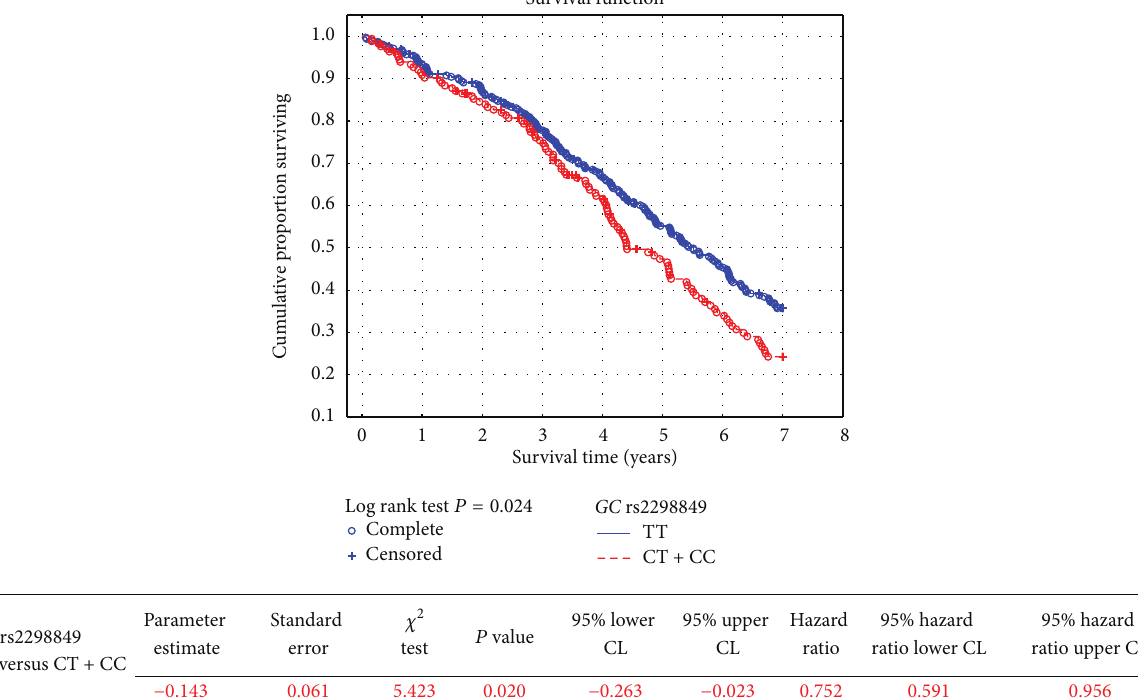
Figure 1: The probability of survival in hemodialysis patients in respect to GC rs2298849 polymorphic